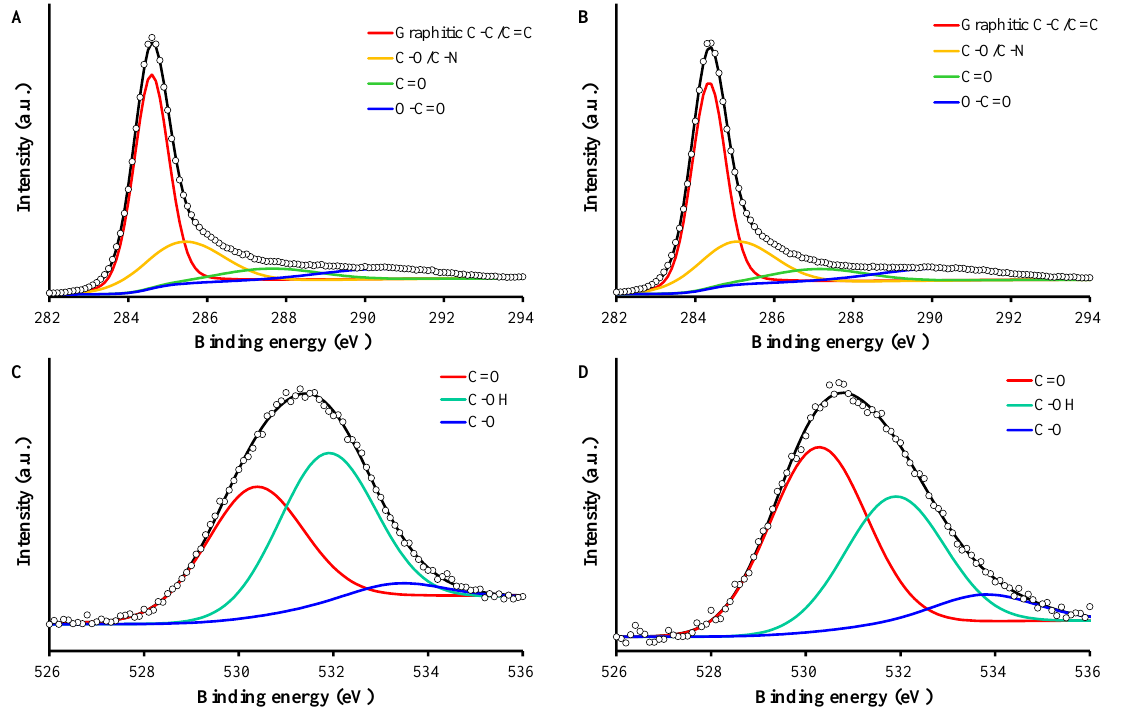
Figure 5. C1s and O1s XPS spectra of ( A , C ) PAC and ( B , D ) PAC900.